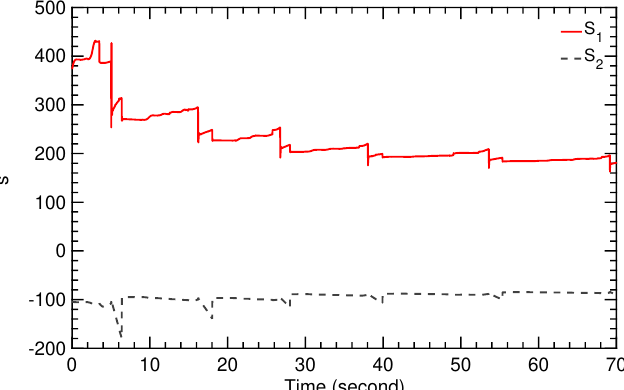
Figure 23. Time history of controller parameters s 1 and s 2 for flight condition